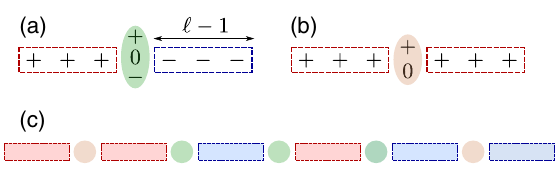
FIG. 6. Constructing frozen states for arbitrary finite-range interactions. For interactions of maximal range l , one can create frozen patches of 2 l − 1 sites with a flippable spin surrounded by domains of (a) opposite or (b) the same charges (shown here for l ¼ 4 , relevant for H H 3 þ 4 ). These can then be combined to cover the entire chain, resulting in exponentially many frozen states, such as the one in